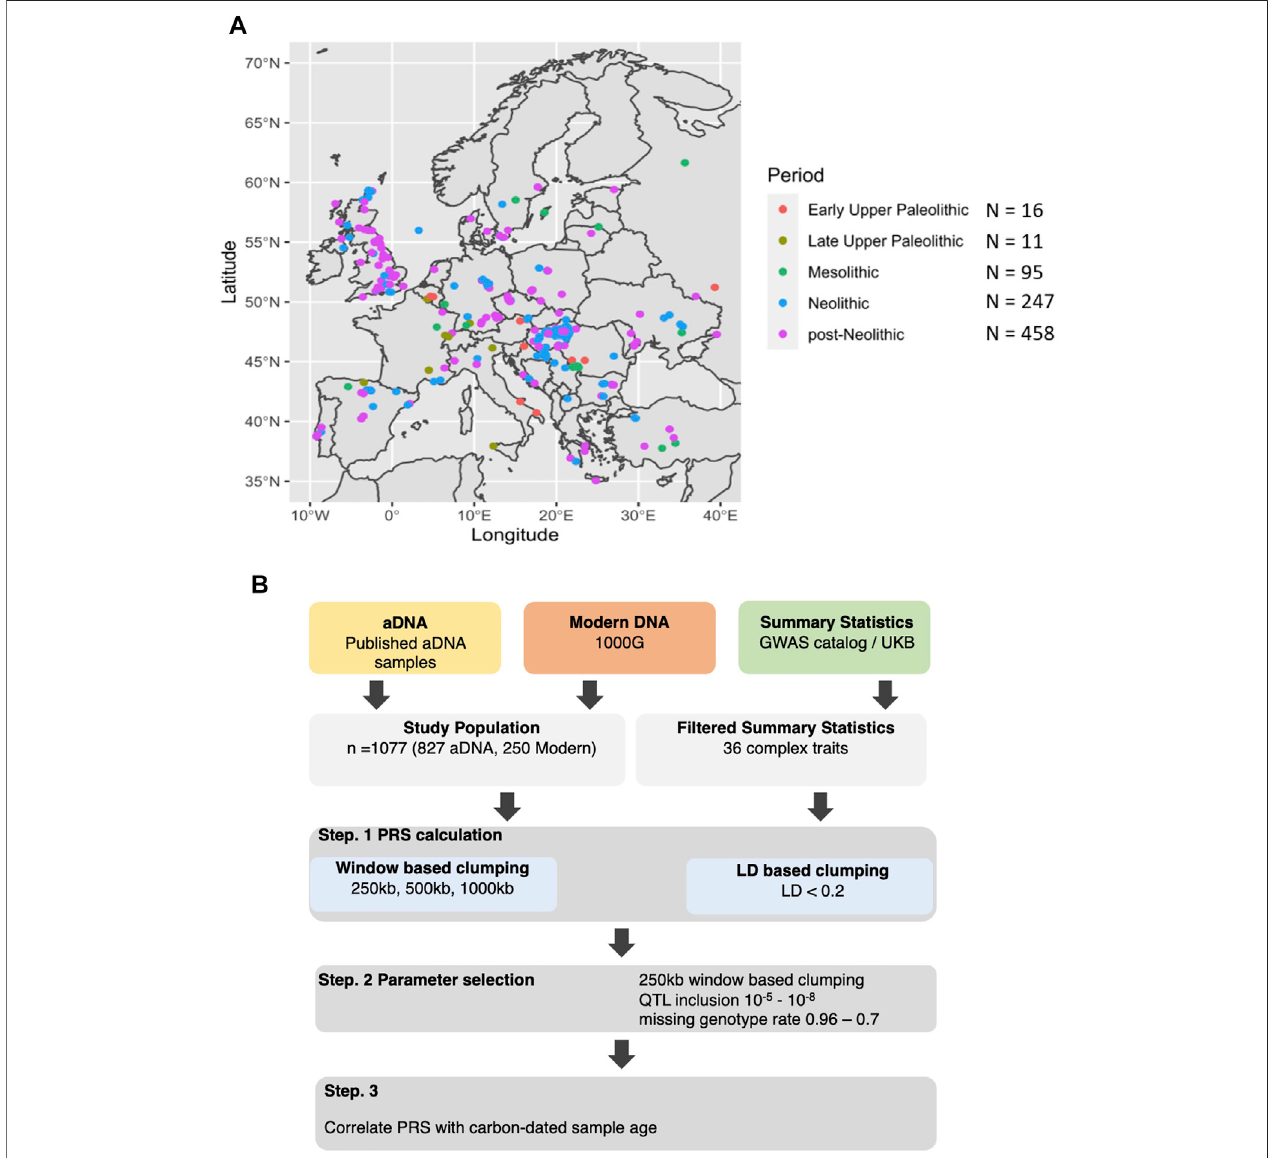
FIGURE 1 | Origin of the samples and analysis performed. (A) Distribution of the ancient DNA samples across Europe colored by a broad historical period ranging from Early Upper Paleolithic, Late Upper Paleolithic, Mesolithic, Neolithic, and post-Neolithic. (B) Both aDNA and modern DNA samples of European individuals were used in combination with summary statistics from predominantly European populations to calculate PRS. This was done at various threshold combinations before correlating the scores with the sample age.